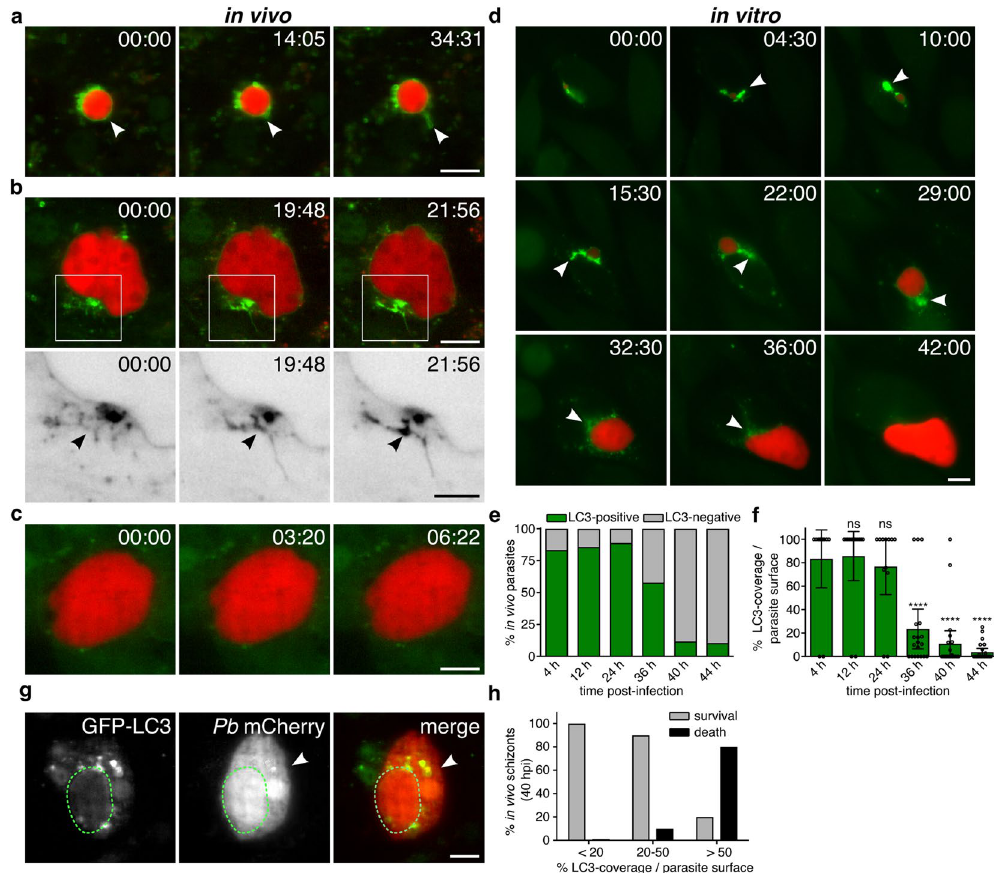
Figure 1. Comparison of the PVM–associated LC3 clearance during liver stage development in vivo and in vitro . (a–c) Liver intravital time-lapse of gfp-lc3 transgenic mice infected with schizonts of different developmental stages. (a) Young Pb mCherry schizont 25 hpi (red) shows LC3 (green) incorporated into the PVM and the dynamic TVN (white arrowhead). Movie interval 2 min. (b) Proliferating liver schizonts 30 hpi accumulating LC3 in the evolving TVN. Lower panel shows magnification of the depicted inset. Arrowhead highlights increasing GFP-LC3 signal in the TVN. Acquisition interval 5 s. (c) Mature Pb mCherry schizont 44 hpi (red) entirely cleared from PVM-associated LC3 (green). Movie interval 2 s. (d) Wide field in vitro time-lapse microscopy of GFP-LC3 expressing HeLa cell (green) infected with mCherry expressing parasites (red). Long-term movie of the P. berghei liver stage showing the accumulation of GFP-LC3 in the evolving TVN (white arrowhead) and a progressive loss from the PVM. With completion of parasite division, LC3 is completely lost from the PVM. Imaging interval 30 min. (e–h) In vivo quantification of the LC3 accumulation at the PVM at indicated times of the liver stage development. (e) Stacked column graph of the overall percentage of LC3-positive and -negative parasites. (f) LC3-coverage of the PVM normalized to parasite surface area. (g) Still image of a liver intravital movie showing the elimination of mature schizonts. Green area outlines the PVM. The necrotic schizont shows release of parasite mCherry into the host cytoplasm (white arrowhead) (h) Quantification of the parasite survival rate in correlation to the LC3-load measured at the PVM. Time stamps, min:s (a–c) and h:min (d) . Scale bars, 10 µ